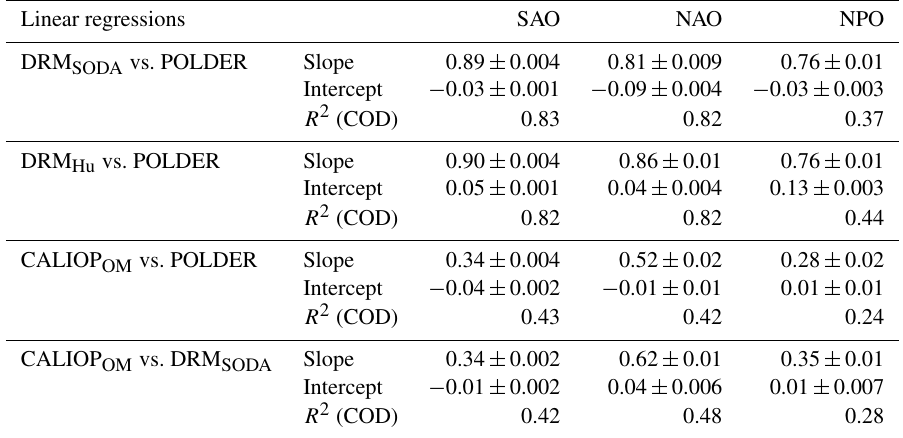
Table 2. Linear regressions of AOT calculated between different methods for data acquired over 6 months (May to October 2008), over three different regions: South Atlantic Ocean (SAO), North Atlantic Ocean (NAO) and North Pacific Ocean